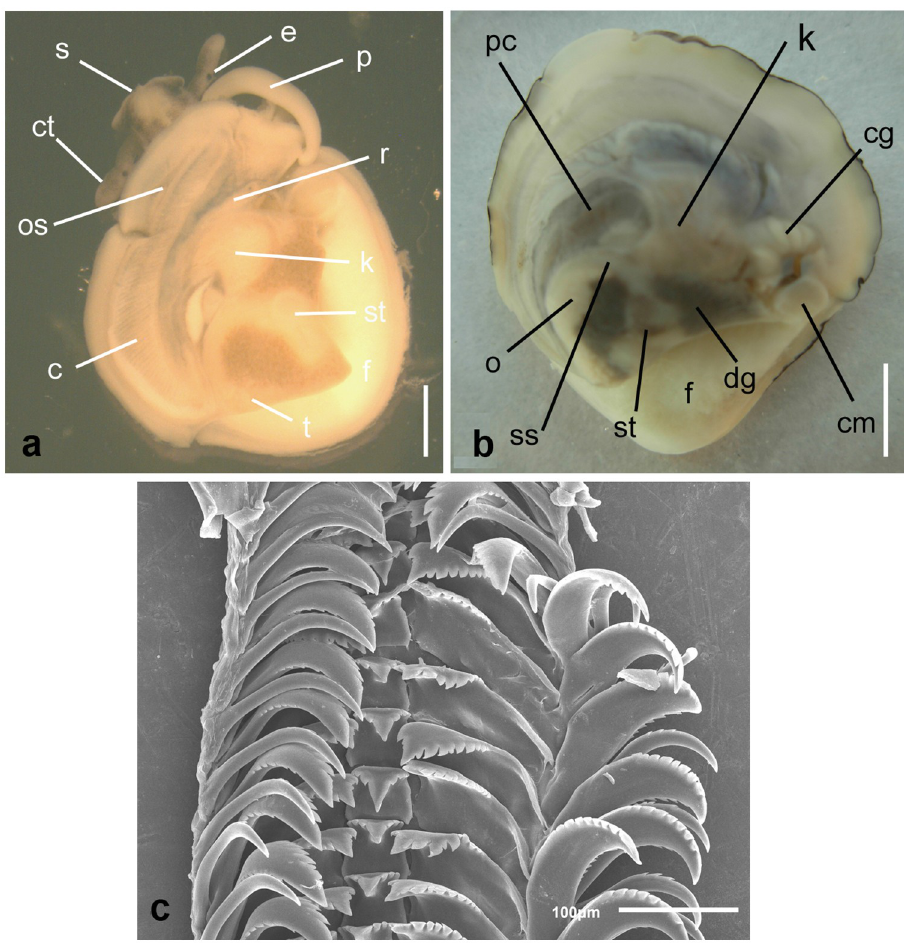
Fig 2. External gross anatomy and radula of Crepipatella dilatata . Dorsal view of a functional male (A) and a functional female (B) extracted from their shells. (C) The radula of a female from O Grove. Abbreviations: c, ctenidium; cg, capsule gland; cm, columellar muscle; ct, cephalic tentacle; dg, digestive gland; e, eye; f, foot; k, kidney; o, ovary; os, osphradium; p, penis; pc, pericarcium; r, rectum; s, snout; st, stomach; ss, style sac. Scale bars: A = 1 mm; B = 5